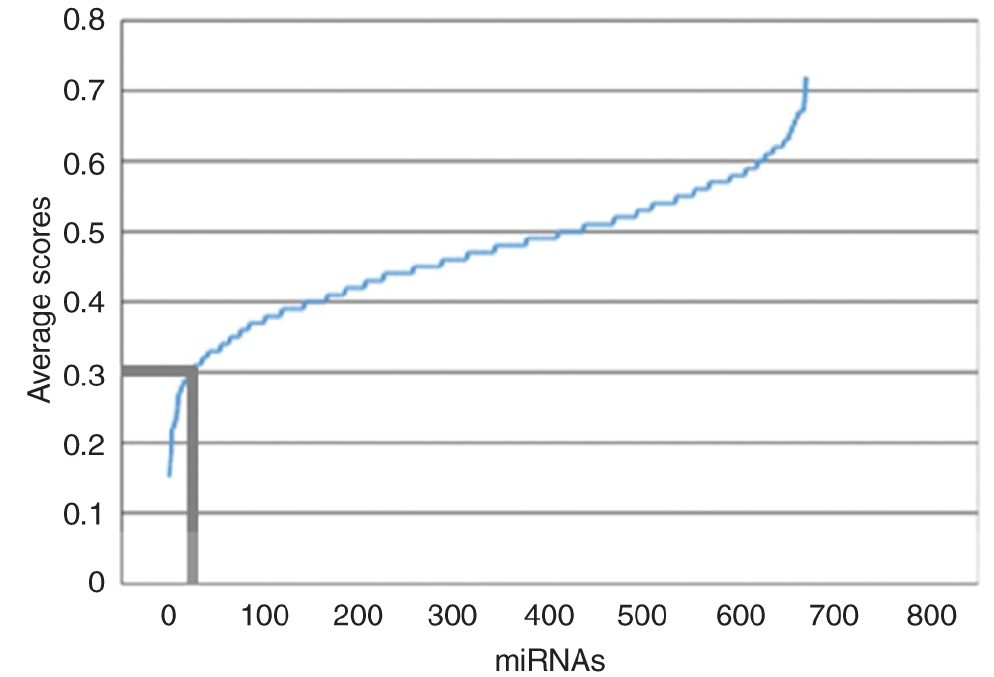
Figure 5: Distribution of average miR2GO scores for miRNA families. There are 26 miRNA families with an average miR2GO score of 0.3 or